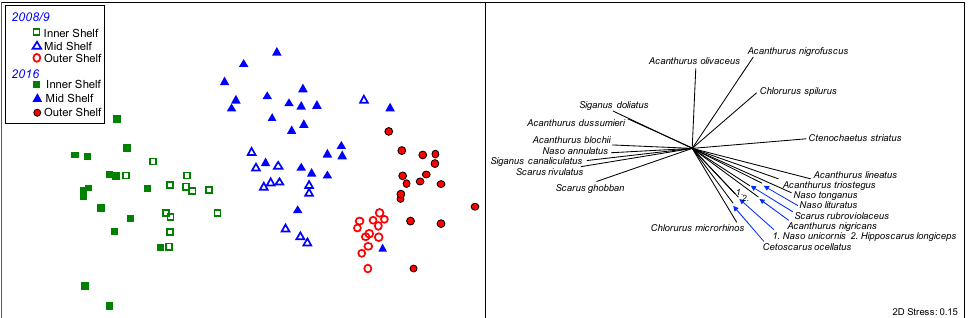
Figure 2. Cross-shelf differences (fitted values 95% confidence intervals) in ( a ) total hard coral cover (%) and ( b ) total macroalgal cover (%) in 2008/9 (white) and 2016 (black).